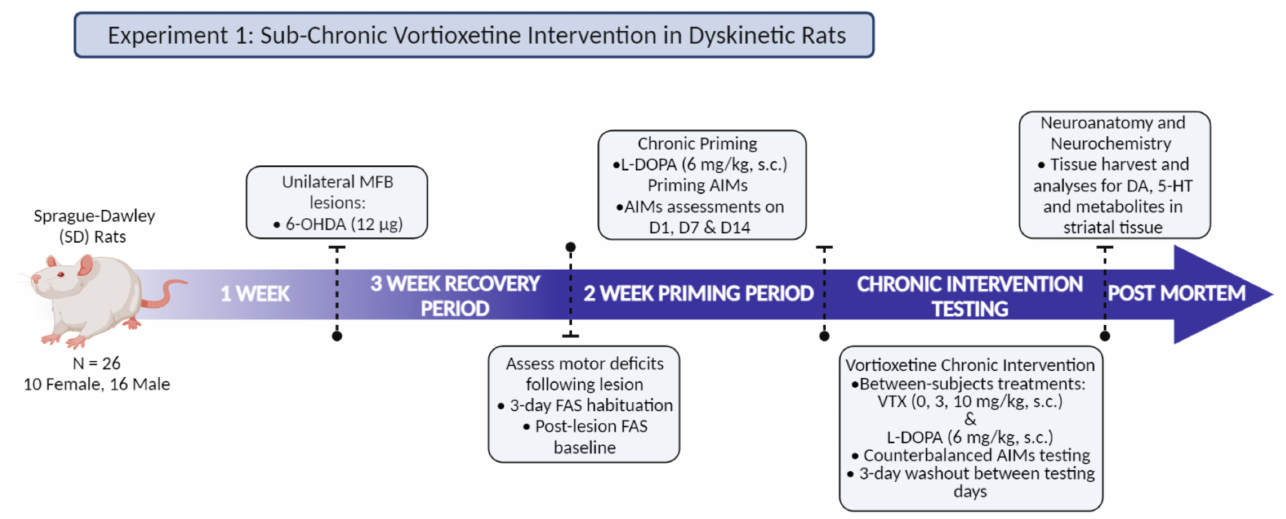
Figure 1. Experimental Design 1: Chronic Vortioxetine Intervention in Dyskinetic Rats.